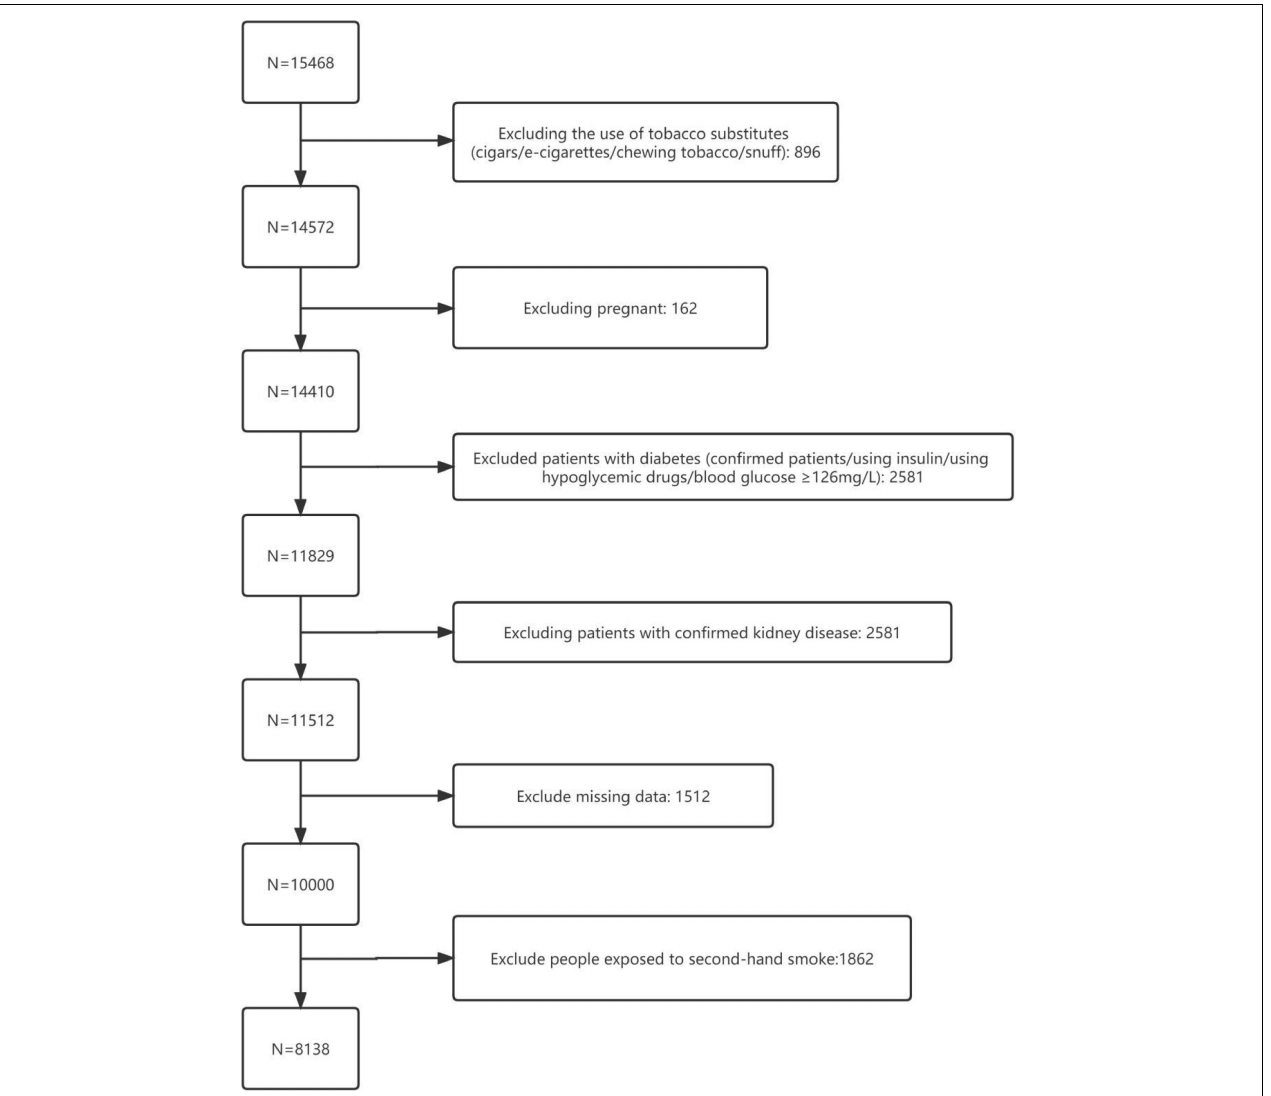
FIGURE 1 | Standard population screening